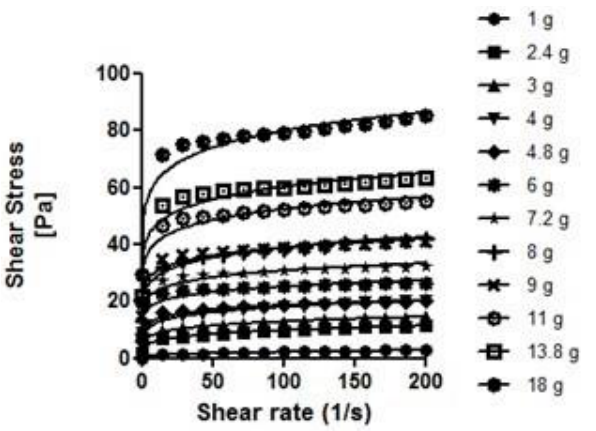
Figure 2. Flow curves at different concentrations of NC in water. Solid line represents the Ostwald de Waele rheological model.